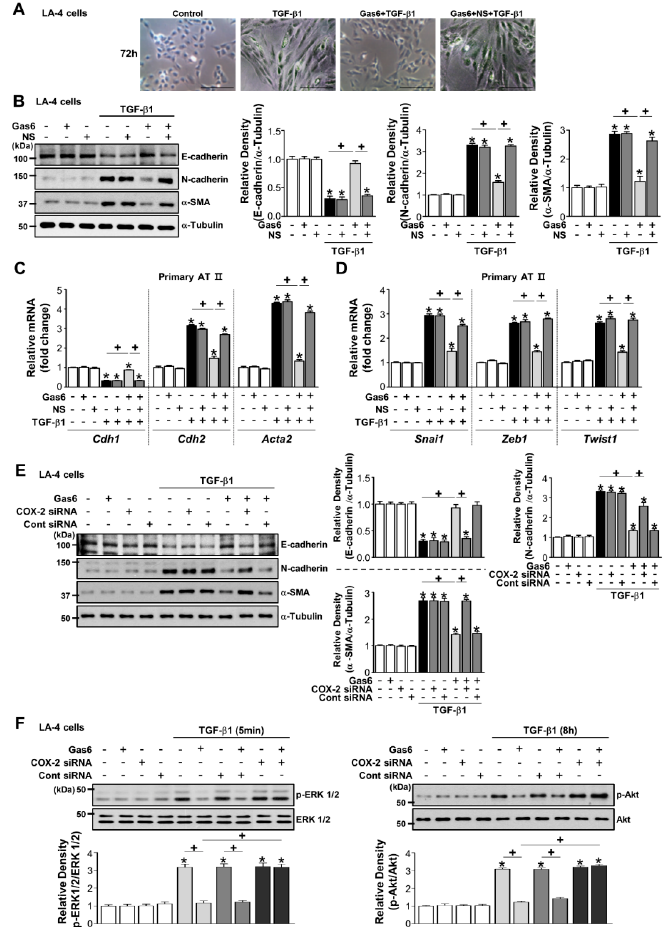
Figure 4. Cyclooxygenase (COX)-2-derived signaling mediates growth arrest-specific protein 6 (Gas6)-induced epithelial-mesenchymal transition (EMT) inhibition. ( A – D ) LA-4 ECs were pretreated with 10 µ M NS-398 1 h before 400 ng / mL Gas6 treatment for 20 h and then stimulated with 10 ng / mL TGF- β 1 treatment for 72 h. ( A ) Morphological changes in the cells were examined by phase-contrast microscopy. Scale bars = 50 µ m. ( B ) Immunoblots of total cell lysates were performed with anti-E-cadherin, -N-cadherin, or - α -SMA antibodies. Densitometric analysis of the indicated EMT markers’ relative abundances. ( C , D ) Primary AT II cells were pretreated with 10 µ M NS-398 1 h before 400 ng / mL Gas6 treatment for 20 h and then stimulated with 10 ng / mL TGF- β 1 treatment for 72 h. qPCR analysis of the mRNAs of EMT markers and EMT-regulating transcription factors. ( E , F ) LA-4 ECs were transfected with COX-2-specific or control siRNAs for 6 h prior to treatment with 400 ng / mL Gas6 for 20 h and then stimulated with 10 ng / mL TGF- β 1 for 72 h or the times indicated. Representative immunoblotsof LA-4 EC lysates were performed with anti-E-cadherin, -N-cadherin, - α -SMA, -total / phosphorylated ERK1 / 2, and -Akt protein antibodies. Densitometric analysis of the indicated protein abundances. Data in all bar graphs are the mean ± S.E. of three independent experiments. * P < 0.05 compared with control; + P < 0.05 as